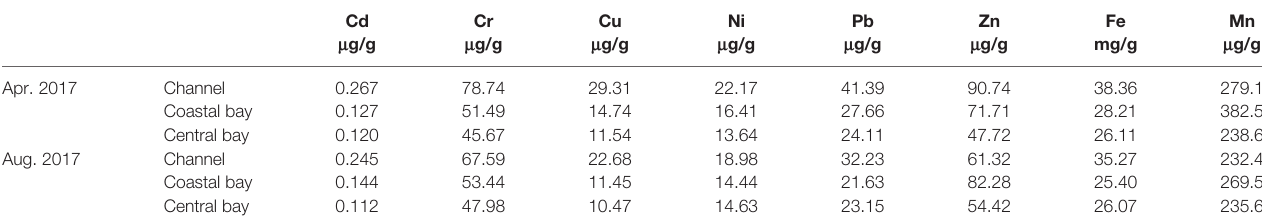
TABLE 3 | The average concentrations of total metals in different subregions of Zhanjiang